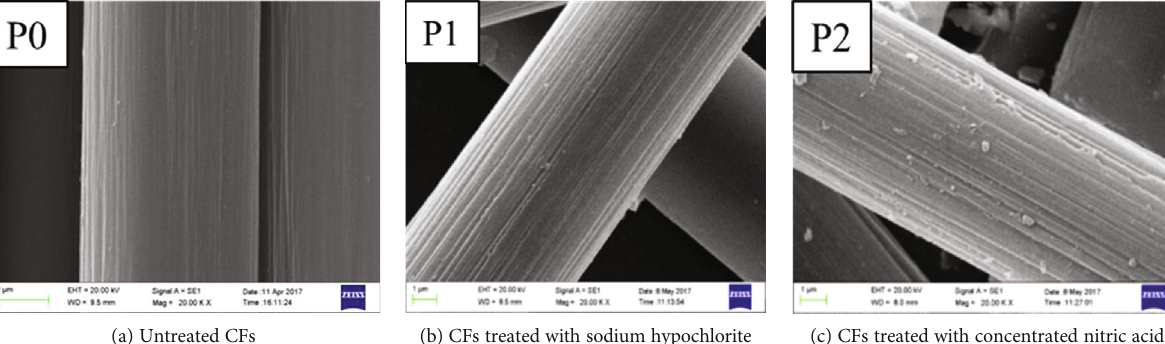
Figure 2: Scanning electron micrographs of carbon fi